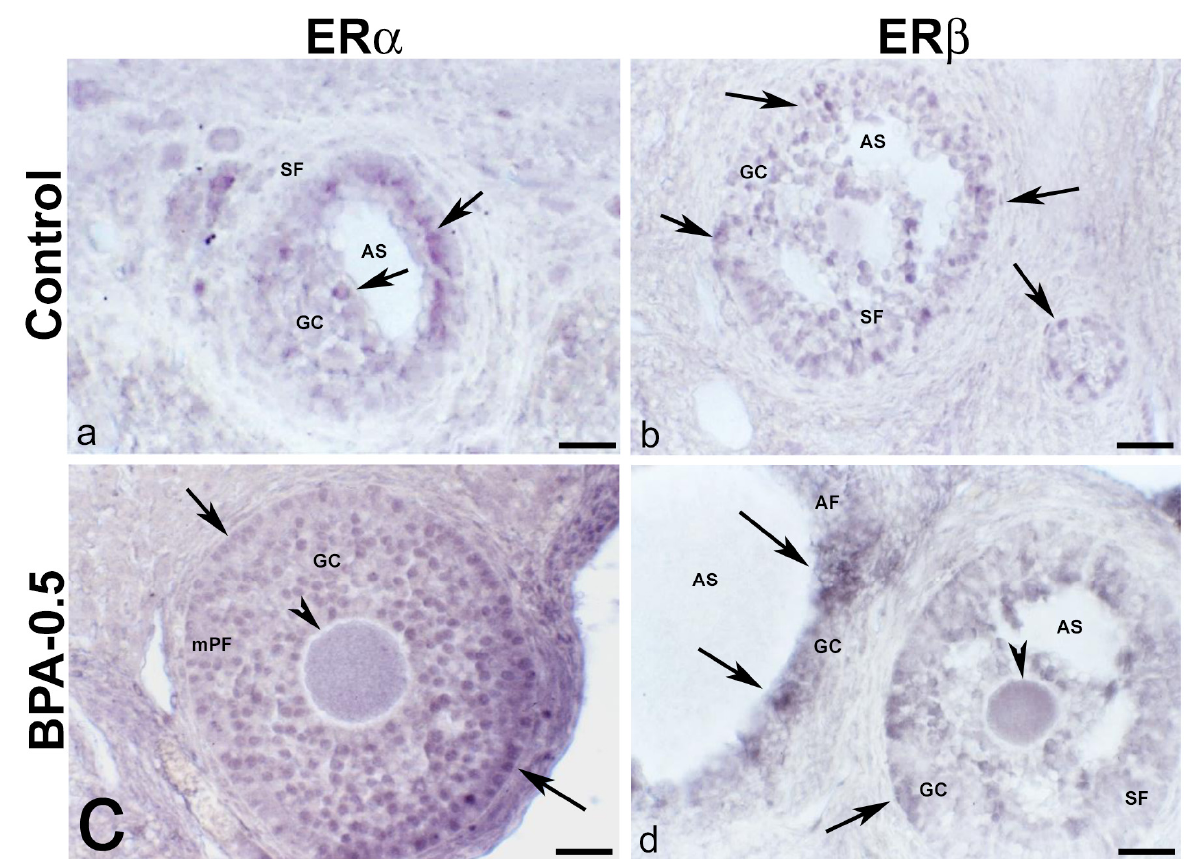
Figure 13. ER α and ER β immunoreactivity in the mother’s ovaries. Representative images of the ovary in mothers after weaning/lactation, showing the presence of ER α -ir ( a , c ) and ER β -ir ( b , d ) in oocytes (arrowheads) and granulosa cells (arrows) from multi-layered primary follicle, secondary and antral follicles in the control and BPA-0.5 groups. AF: antral follicle; AS: antral space; GC: granulosa cells; mPF: multilayered primary follicle; SF: secondary follicle. Scale bars: ( a – d ): 60 µm.